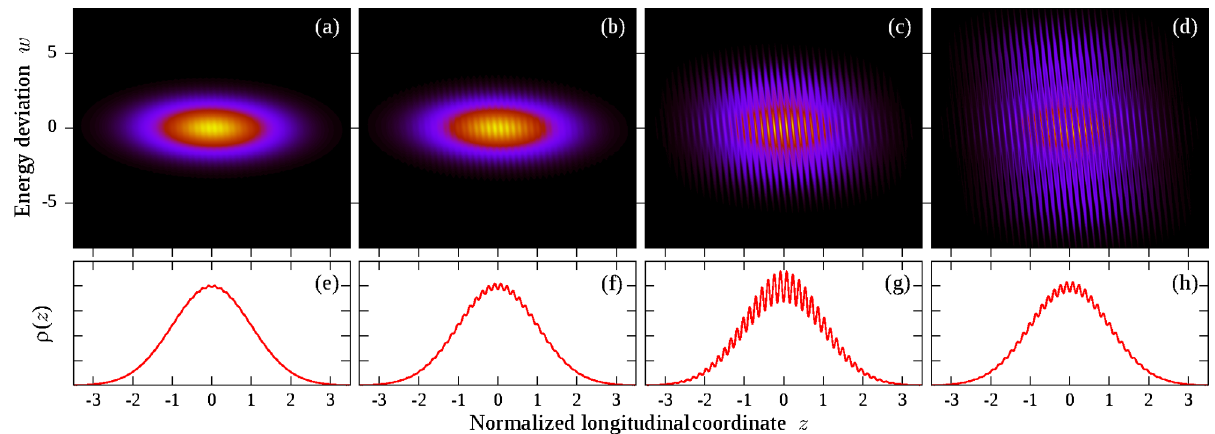
FIG. 1. Illustration of the saturation process in a simplified case where the laser pulse is infinitely long, and the magnetic transport involves only longitudinal dynamics (more precisely r 51 ¼ r 51 ¼ 0 and r 56 (cid:1) 0 ). The upper [(a)–(d)] and lower rows [(e)–(h)] represent the longitudinal phase space, and the longitudinal density profile (cid:2) ð z Þ respectively, at the emission point for increasing laser power. The tilt of the modulation pattern has a fixed angle determined by the magnetic transport parameter r 56 . The increase in laser power leads to a monotonic increase of energy modulation. However, the modulation amplitude in the vertical projection (or equivalently the bunching factor) increases up to an absolute maximum [from (a) to approximately (c)]. Then the amplitude of the density modulation begins to decrease and remains below this absolute maximum. The model used in this simulation is described in Ref. [11], and the parameters used for the illustration are r 56 ¼ 0 : 4 , k m ¼ 40 , w 0 ¼ 0 : 03 for (a), w 0 ¼ 0 : 06 for (b), w 0 ¼ 0 : 3 for (c), and w 0 ¼ 0 : 6 for (d) . The longitudinal coordinate is expressed in units of the initial bunch length. Calculations made in the paper will be performed including 3D beam transport and a finite duration laser